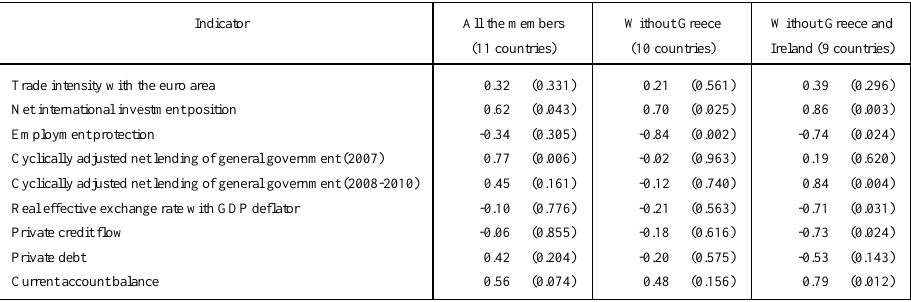
Table 1. Correlation coefficients between the change in output comovements and its potential